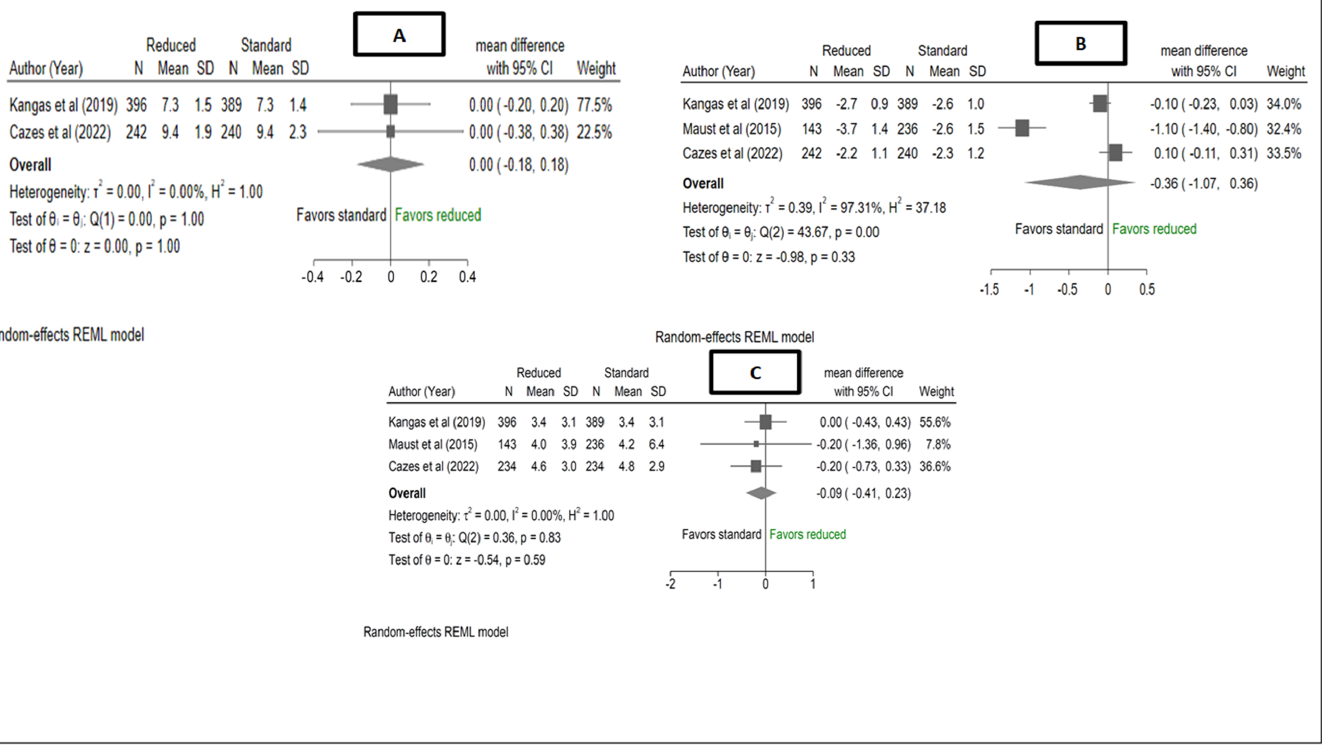
Figure 3. Forest plots of ( A ) mean weight and ( B ) rate of weight gain from admission to discharge (Kangas et al. Maust et al. [12,13]) and at 6 months (Cazes et al. [14]), and ( C ) mean change in WAZ at recovery from a meta-analysis of studies comparing reduced RUTF dose with standard RUTF dose for the treatment of severe wasting and/oedema. Effect estimates for Cazes et al. (means and standard deviations) were obtained directly from the authors. Mean weight in Cazes was assessed at six months, whereas for Kangas, it was assessed at discharge. Mean WAZ in Kangas et al. [12] was assessed at recovery whereas, for Cazes et al. [14] it was assessed at 6 months from baseline. Only ITT results were meta-analysed, for both studies.